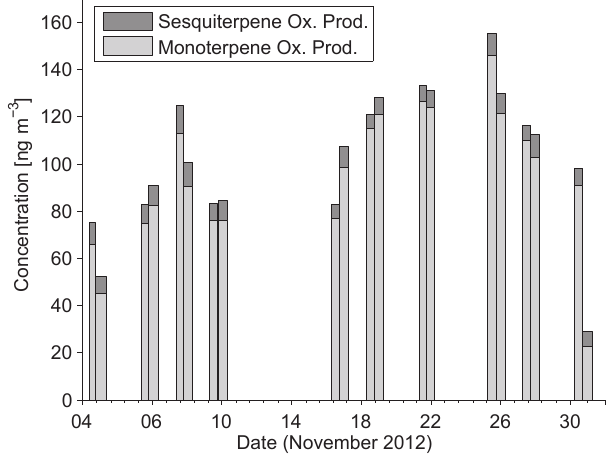
Figure 34. Concentration of monoterpene and sesquiterpene oxida- tion products in ambient aerosol collected in November 2012 over the Amazon rain